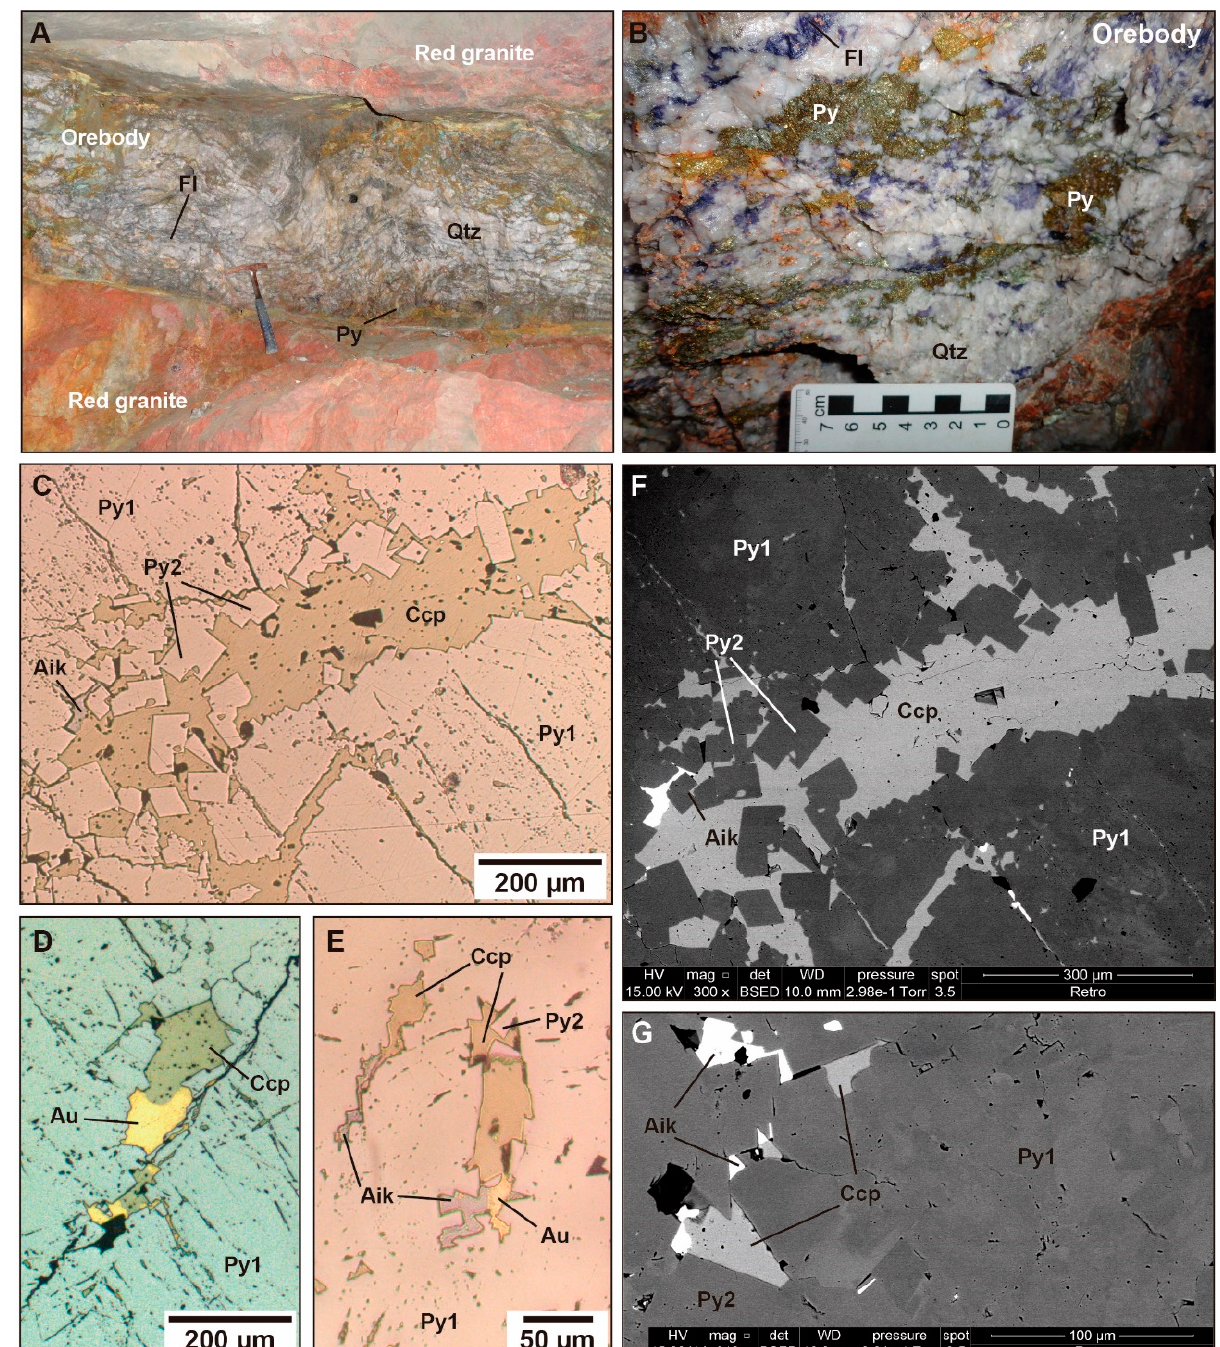
Figure 3. ( A ) Ore vein composed mainly of quartz, sulphides (pyrite, chalcopyrite), and fluorite (outcrop view); ( B ) Photograph of a quartz vein with the ore paragenesis at the outcrop; ( C ) Photomicrograph of the ore paragenesis showing the two pyrite generations (Py2a, Py2b), chalcopyrite, aikinite, and gold; ( D , E ) Photomicrographs of the ore paragenesis of pyrite + gold + chalcopyrite ( D ) and pyrite + gold + chalcopyrite + aikinite ( E ); Figures ( F , G ) are SEM/BSE images showing the distribution of pyrite 2a, pyrite 2b, chalcopyrite, and aikinite. Images ( C – E ): optical microscopy—